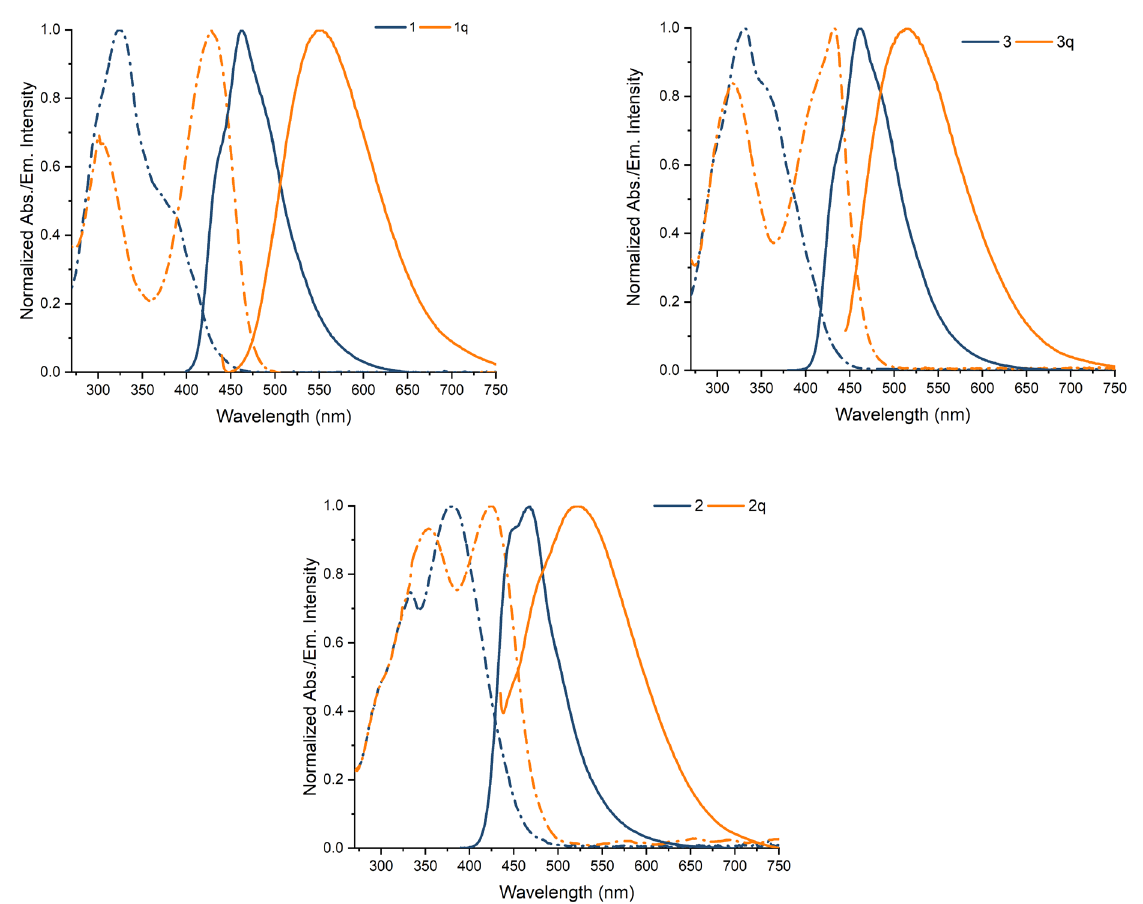
Figure 3. Absorption (dash–dotted lines) and emission (solid lines) spectra of 1, 2, 3 (blue) and 1q, 2q, 3q (orange) recorded in DCM solution (concentration 10 − 5 M).